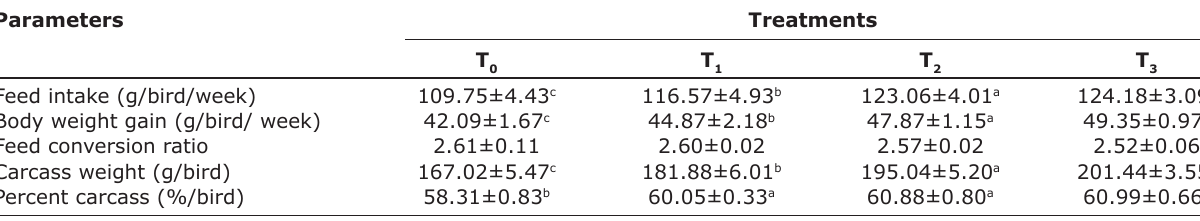
Table-2: Growth performance of native chickens during the starter phase (1-6 weeks). Parameters